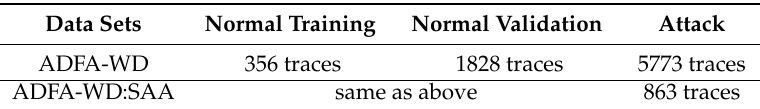
Table 1. Compositions of Data